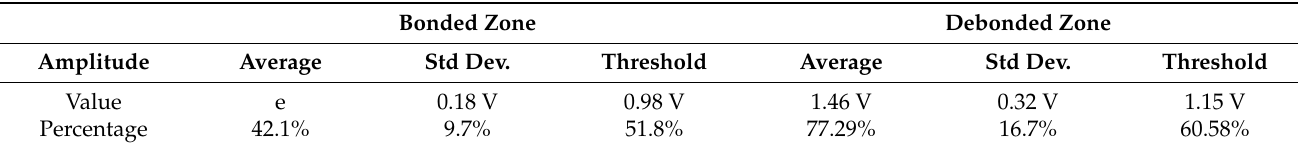
Table 2. Data analysis of the